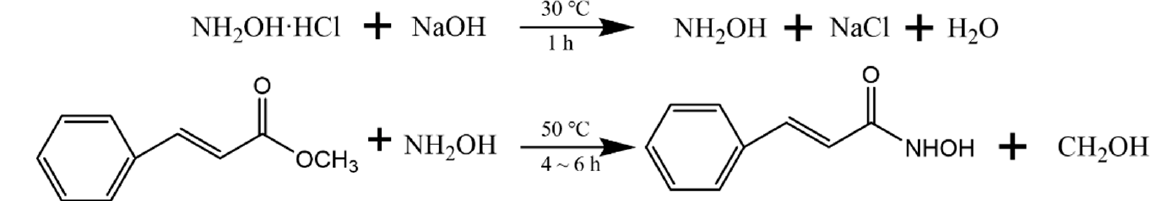
Figure 2. The synthetic route of PHA. The nuclear magnetic resonance spectroscopy (NMR) is shown in Figure 3. Tetramethyl- silane (TMS) was used as internal standard, and deuterium chloroform (CDCl 3 ) was used as solvent. The chemical shifts of hydrogen and carbon atoms in the synthesized product were measured and analyzed using Avance 400 nuclear magnetic resonance instrument, and the structure of the synthesized product was characterized based on the analysis results. The NMR patterns of PHA can be interpreted that 400 MHz 1 H NMR (CDCl 3 , TMS, ppm): δ